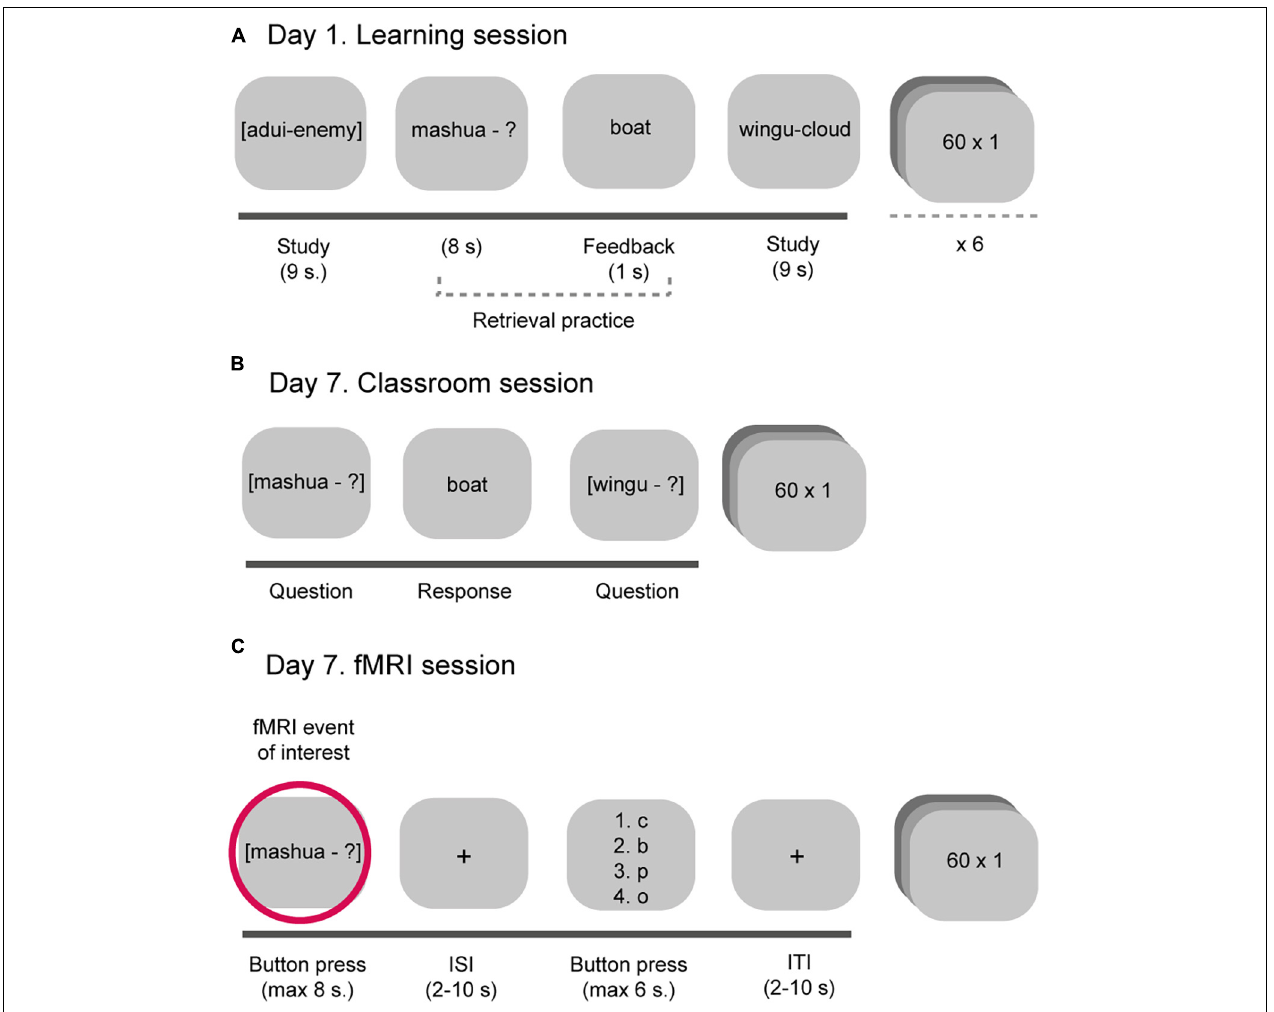
FIGURE 2 | The experimental procedure related to (A) the learning intervention (day 1) and the 1 week retention test in the (B) classroom and the (C) MR